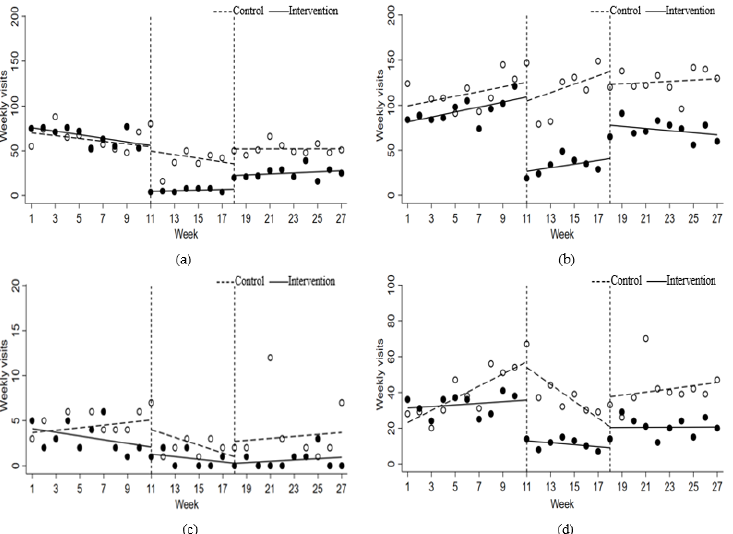
difference of intercept (baseline level) and slope between two groups before lockdown; int 2 & Secondtime : changes of level and slope in control group immediately after regular prevention; group × int 1 and group × posttime : changes in the level and slope of weekly asthma visits after lockdown, reflecting the instantaneous and long-term effects of lockdown after controlling the time-varying confounding factors with control group; group × int 2 and group × Secondtime : changes in the level and slope following introduction of regular prevention and control after lifting lockdown.